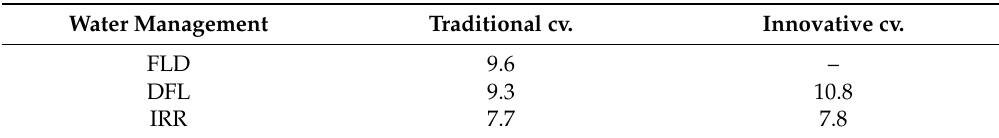
Table 2. Average yield of the three water management options, for traditional and innovative cultivars. Terms expressed in metric